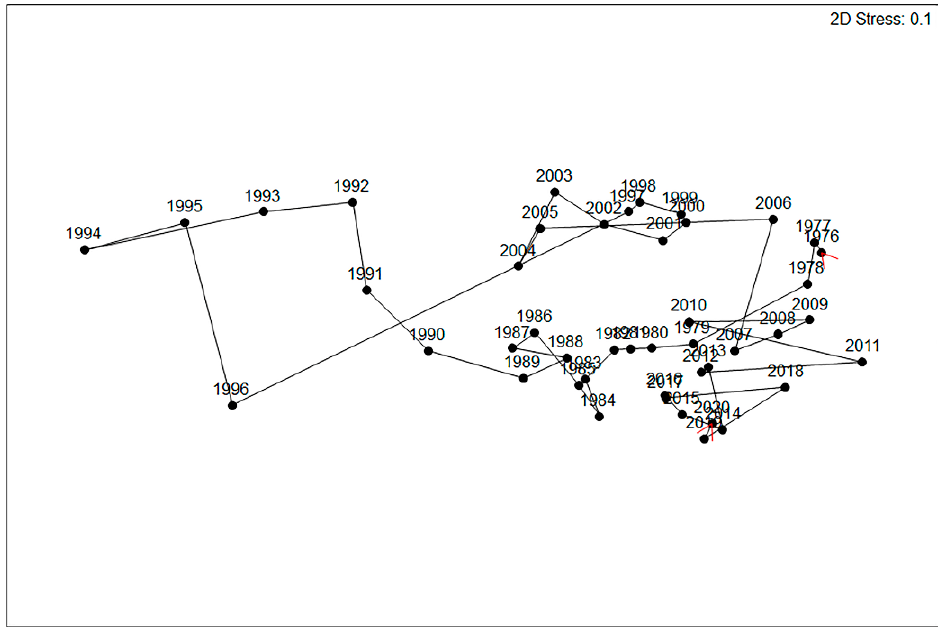
Figure 7. Nonmetric multidimensional scaling ordination based on Bray–Curtis similarities of focal species in different years at the gravel plain study site. Red arrows mark the start and end years of the study. Consecutive years are connected.